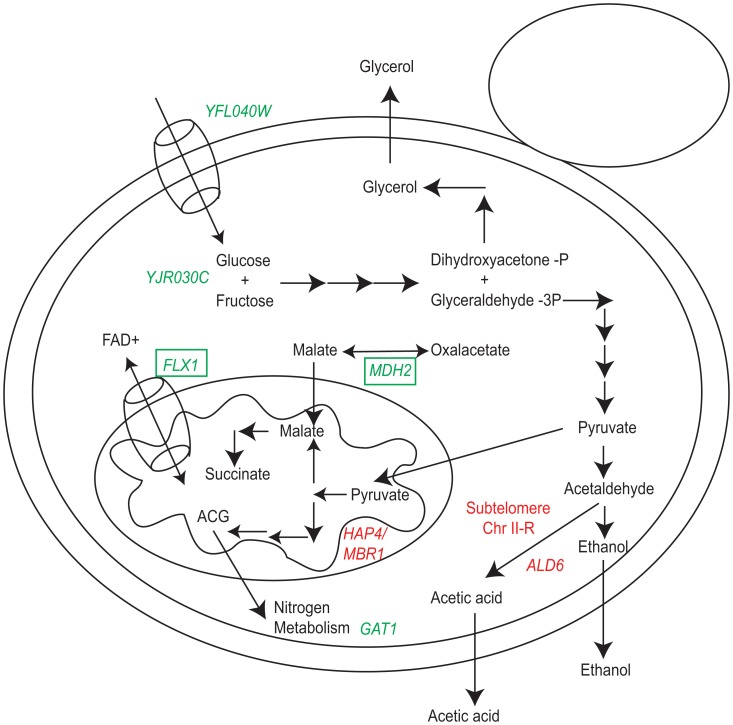
Functional role of winemaking QTLs.Genes that contributed to the natural variation in wine making QTLs are shown. Genes in red and green contribute to the natural variation in the NA x WA and WE x SA crosses, respectively. The green squares indicate genes showing positive epistatic interaction. ACG = α – ketoglutarate. Each arrow shows a metabolic step from one compound to another. See main text for further details.